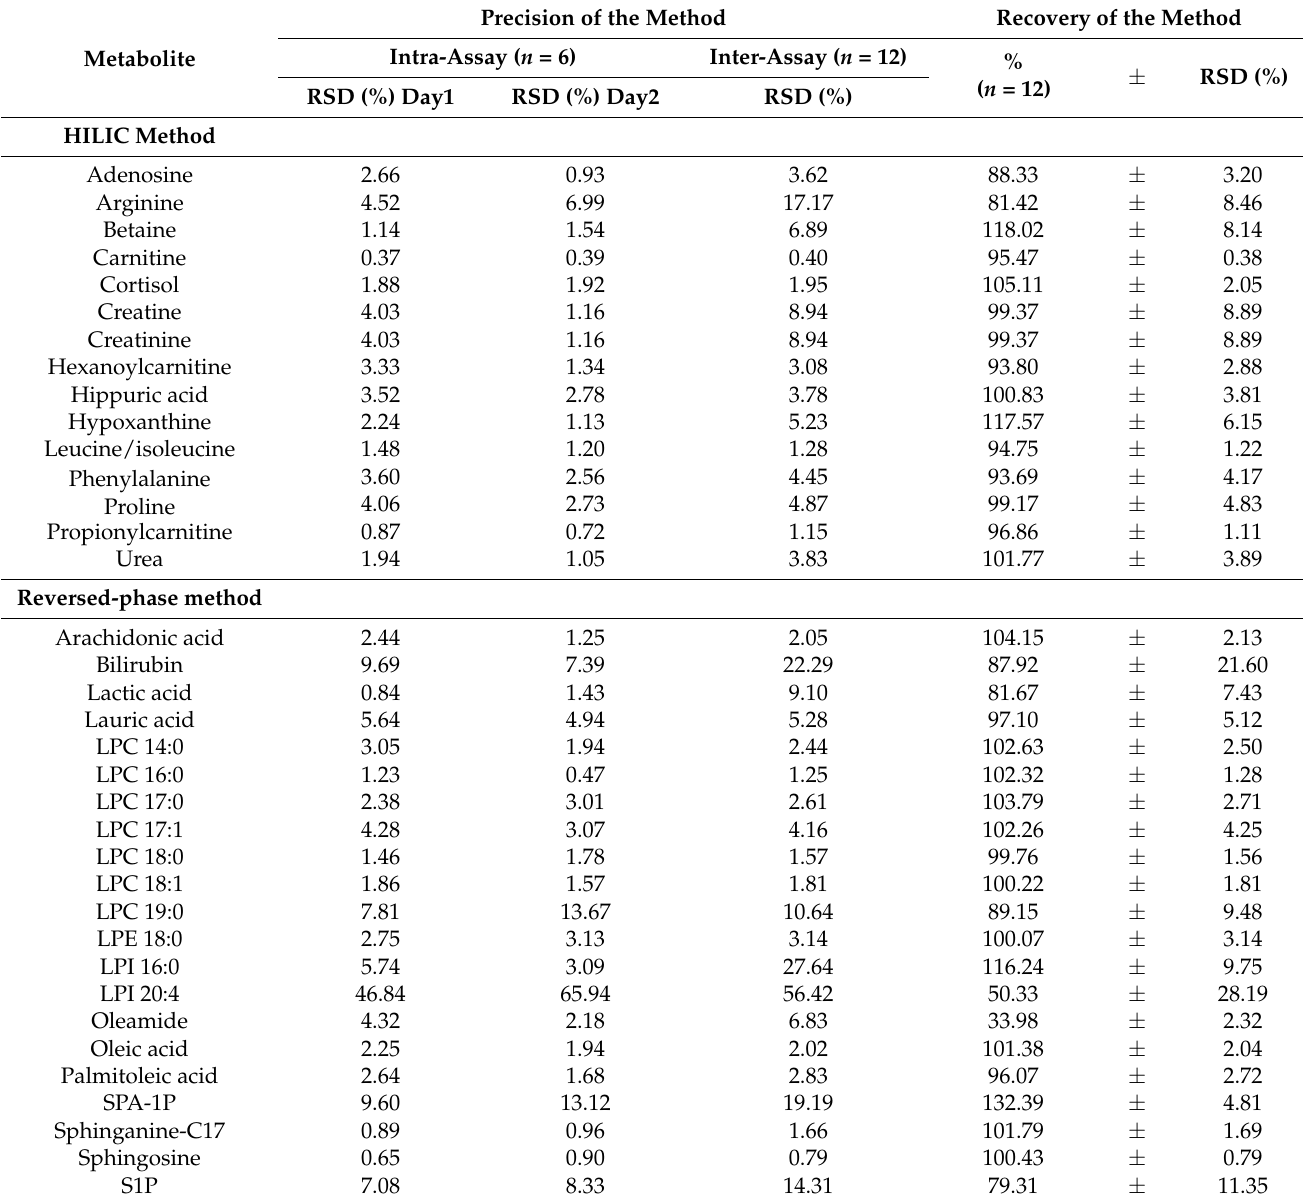
Table 3. Precision and recovery parameters of HILIC and reversed-phase